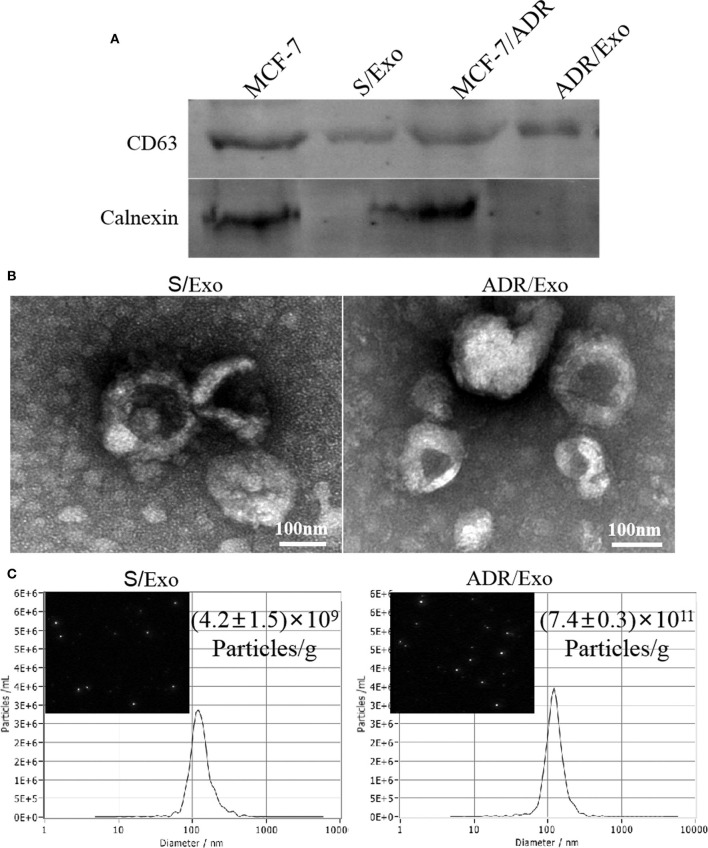
DOX increased the exosomes release of MCF-7/ADR cells. (A) Exosome identification by western blot. These vesicles expressed conventional exosomal markers CD63; calnexin was detected only in total cellular lysates and not in exosomes. (B) The morphology of exosomes was analyzed using TEM, showing a typical “saucer-like” morphology and a diameter of 30–120 nm (scale bar, 100 nm). (C) The size distribution and concentration of A/Exo and S/Exo were analyzed by NTA. The concentration of exosomes was (7.4 ± 0.3) × 1011 particles/g in A/Exo and (4.2 ± 1.5) × 109 particles/g in S/Exo. There were no significant differences in morphology and size distribution between S/Exo and A/Exo (p > 0.05), while the concentration of A/Exo was significantly higher than that of S/Exo (p < 0.05).